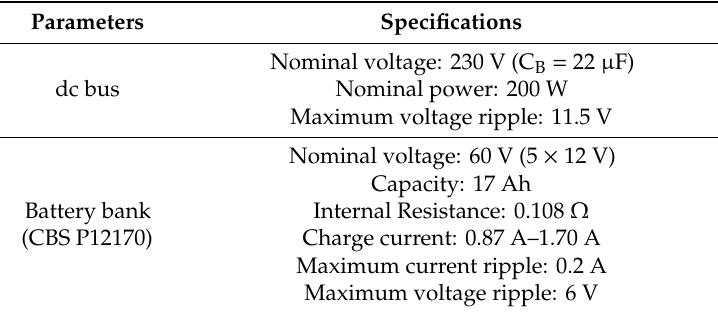
Figure 7. Filters’ design for duty-cycle converter variations. Table 1. Details of designed converter.